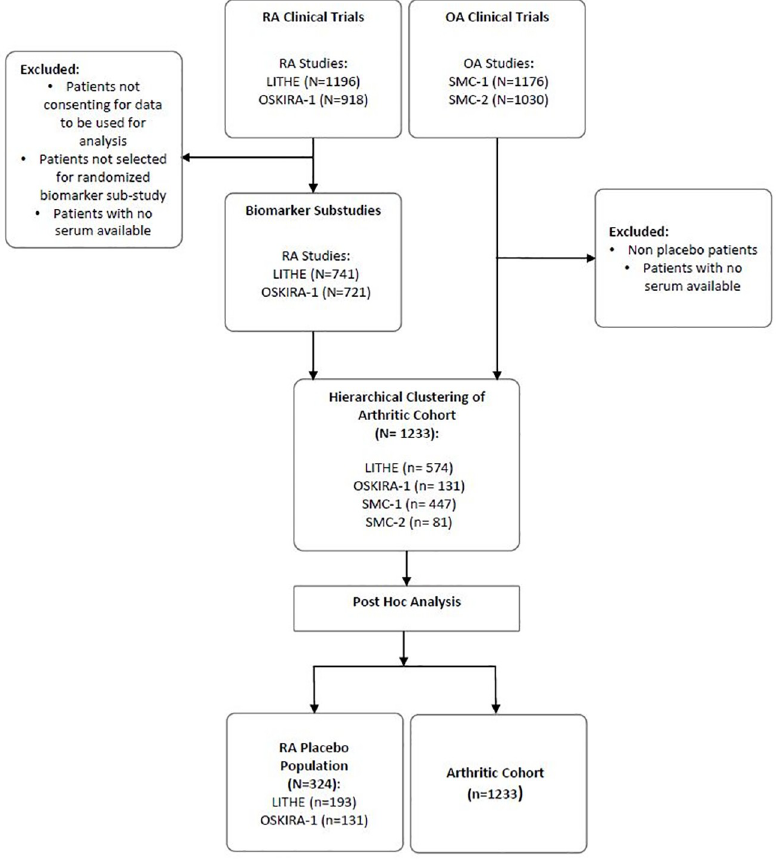
Fig 1. Four biomarker sub-studies of clinical trials were pooled for clustering before further analysis of each cluster. A random selection of patients from the RA clinical trials were selected for biomarker analysis. Patients with missing data from the panel of biomarkers analysed were removed from the study when included in the arthritic cohort.